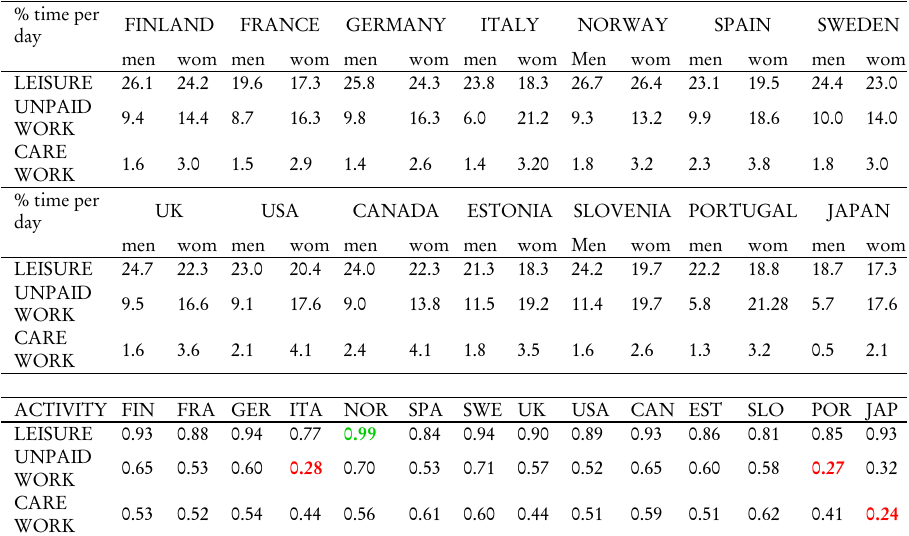
Leisure and M/F for Unpaid and Care work of daily time spent in that activity (% for women and men and F/M